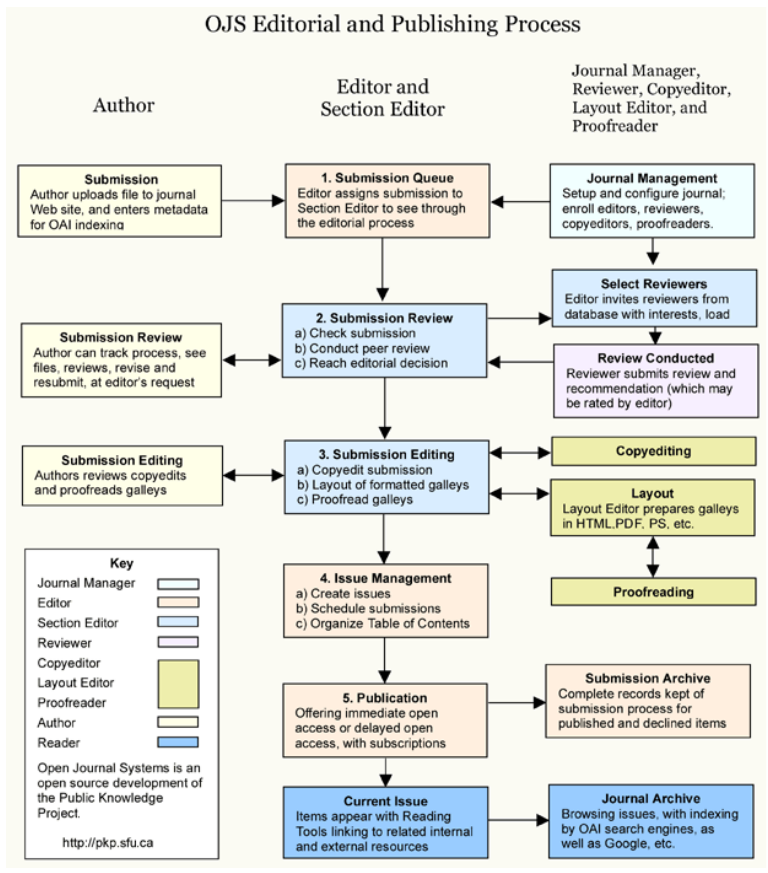
Figure 1 - OJS Editorial and publish process of the